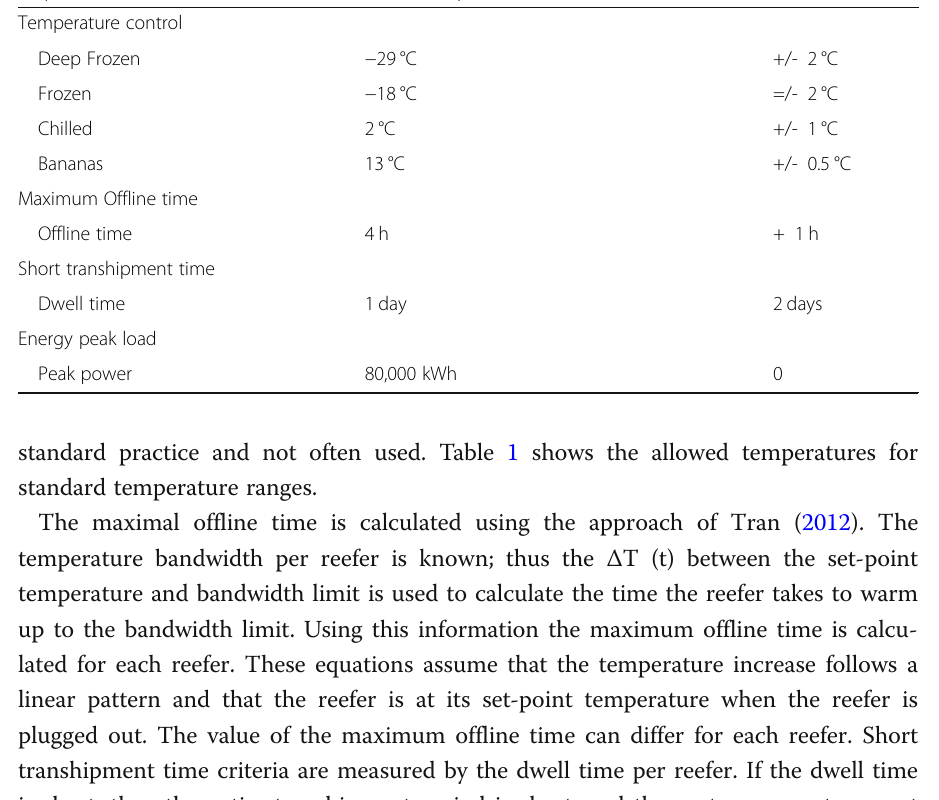
Table 1 Reefer performance standards